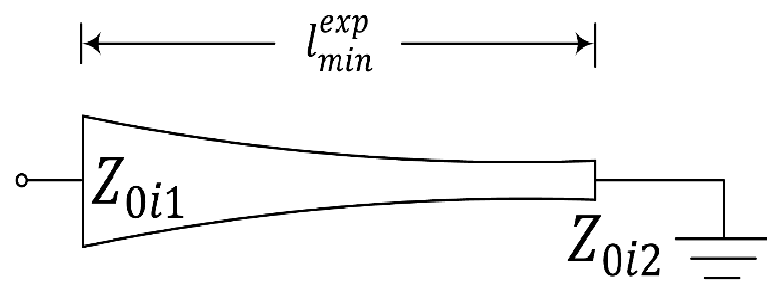
Figure 2. Exponential TTL short-circuited stub.